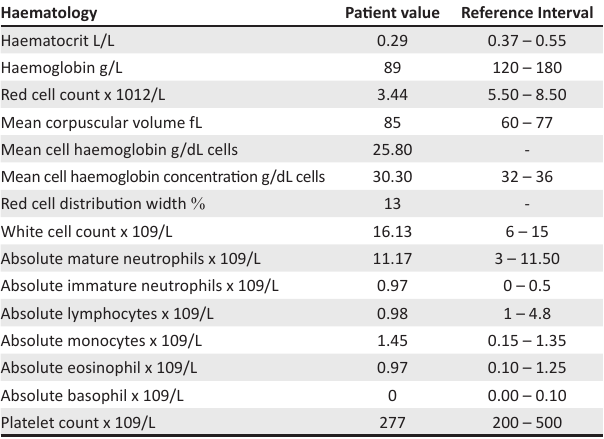
TABLE 2: Haematology results.